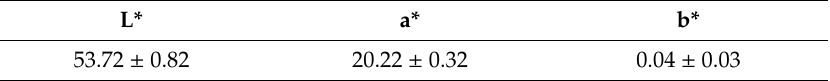
Table 2. CIELAB parameters of the co-microencapsulated